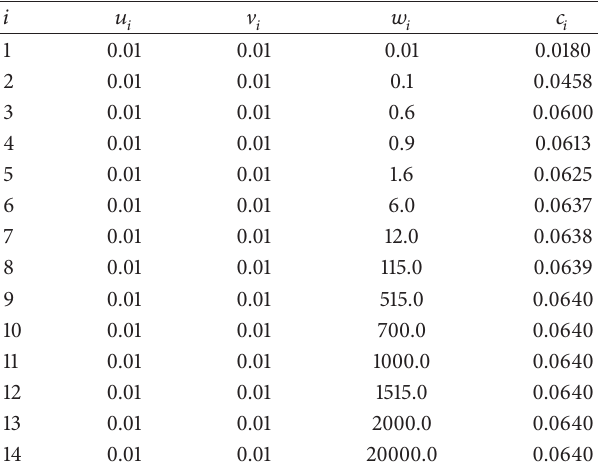
Table 9: Values of 𝑐 𝑖 for several values of shape parameters 𝑢 𝑖 , V 𝑖 , and 𝑤